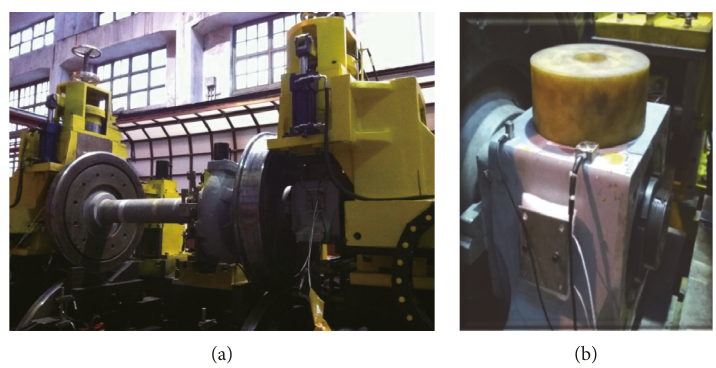
Figure 9: Experimental bench of a wheelset bearing: (a) bench; (b) measurement sensors mounted on the axle box.